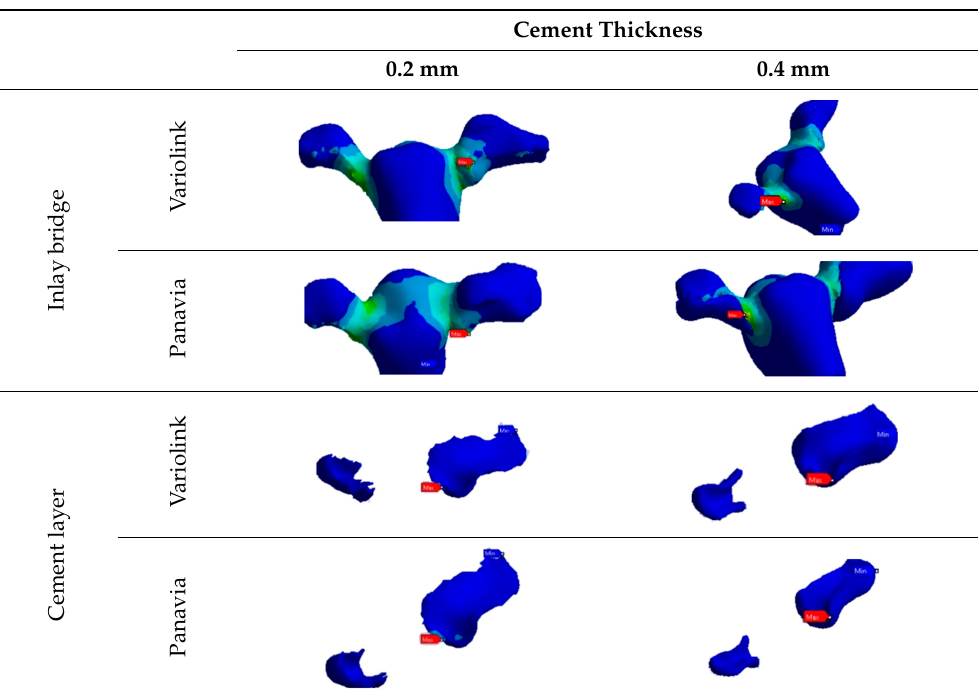
Table 4. Strain distribution on the inlay bridge and the cement layer for both Variolink and Panavia, 0.2 and 0.4 mm. Cement Thickness